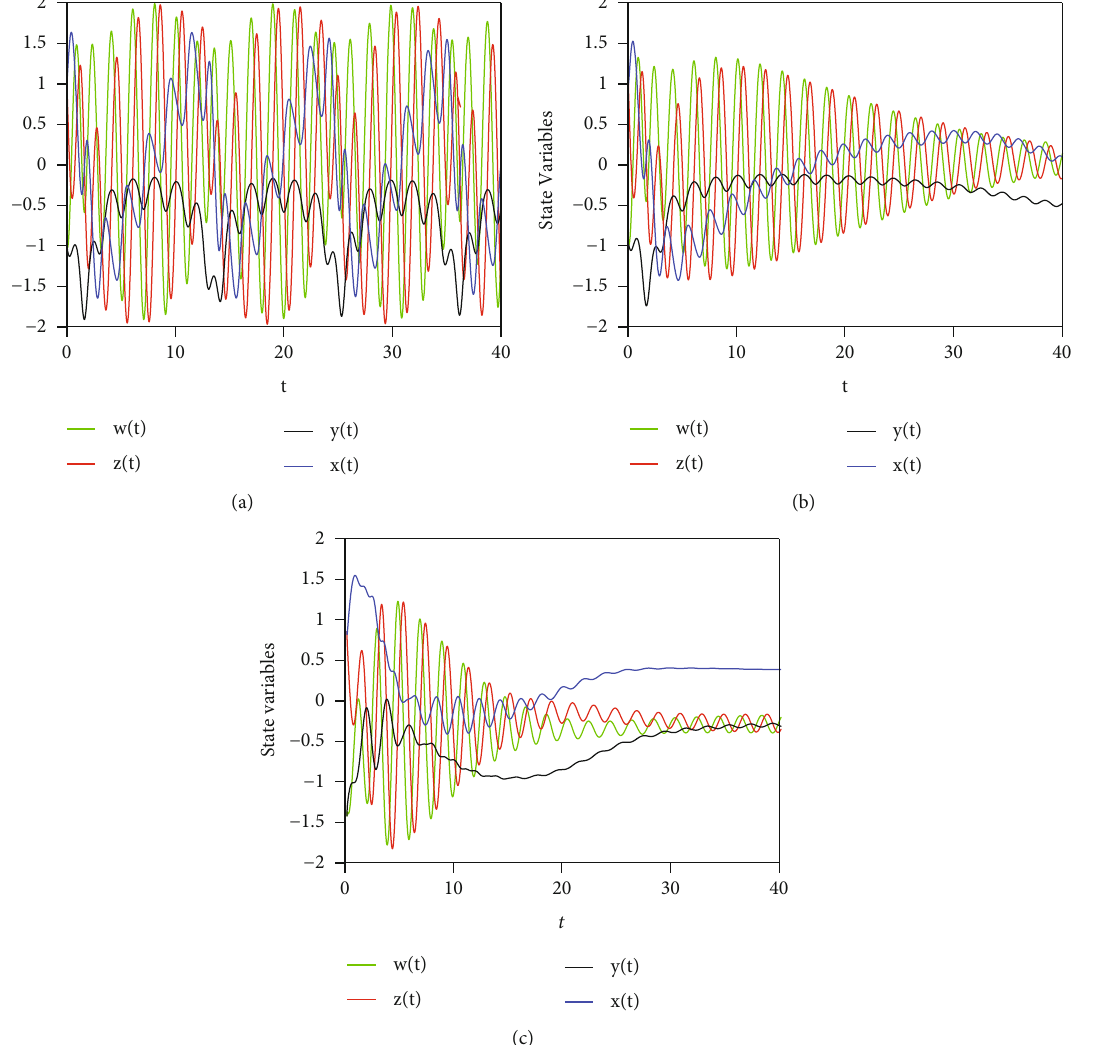
Figure 16: The time-series behavior of di ff erent state variables of system 1 with fractional order ϖ = 0 : 98 and the parameters c = d = 2